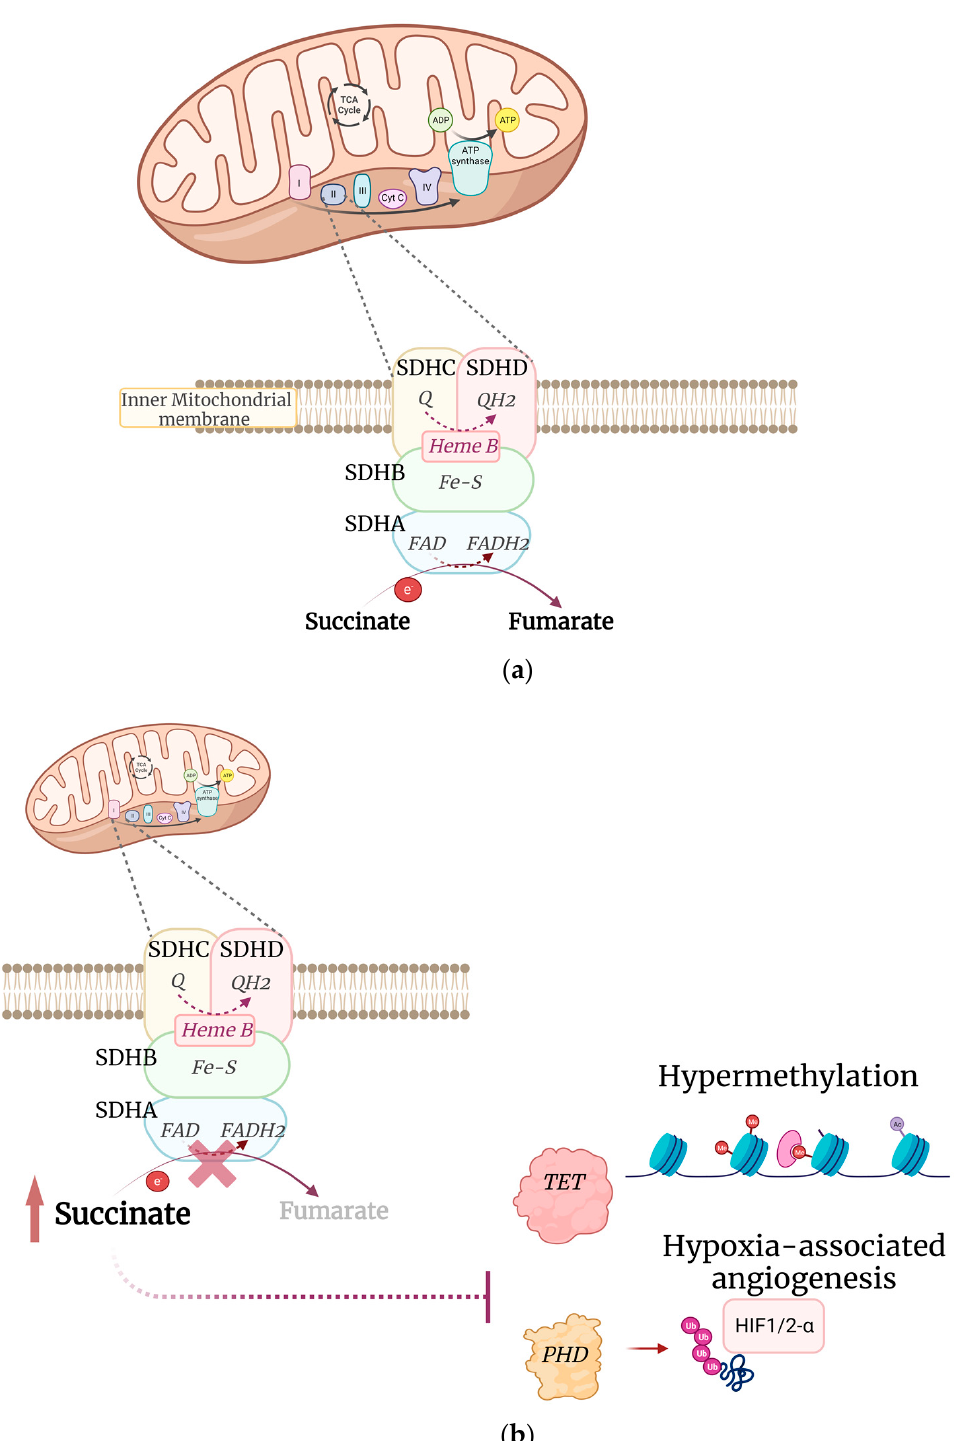
Figure 1. Schematic representation of the SDH complex in physiological ( a ) and pathological ( b ) condition. SDH, succinate dehydrogenase; Q,ubiquinone; QH2,Ubiquinol; Fe–S, iron-sulfur; FAD, flavin adenine dinucleotide; FADH2, dihydroflavine-adenine dinucleotide; e, electron; TET, ten–eleven translocation; Me, methyl group; PHD, prolyl-hydroxylase domain proteins; Ub, ubiquitin; HIF, hypoxia-inducible factor.